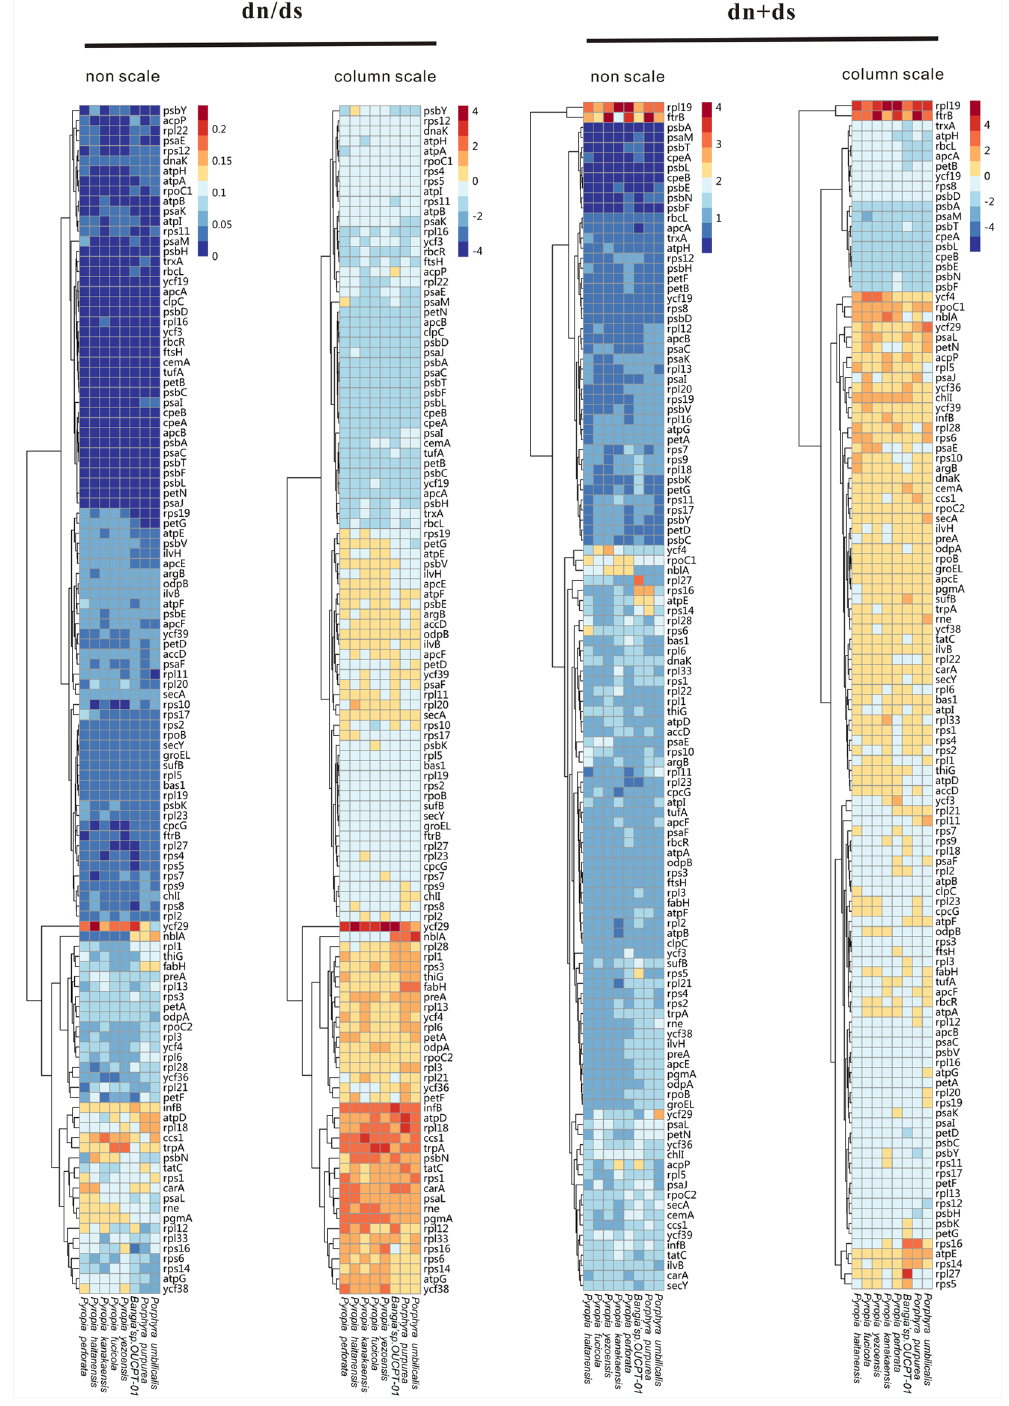
Figure 5. Weighted dN, dS, and dN/dS network analysis in the Bangiales. The figure on the left represents dN/dS and that on the right indicates dN + dS. Various modules are clustered together according to the relative similarities of their dN/dS and dN + dS expression patterns. For the dN/dS network, genes related to photosynthesis underwent strong selection pressure and are clustered in the deep blue module. Genes related to transcription initiation factors, ribosomal proteins and certain ycf-type transcription regulators are clustered in the deep orange